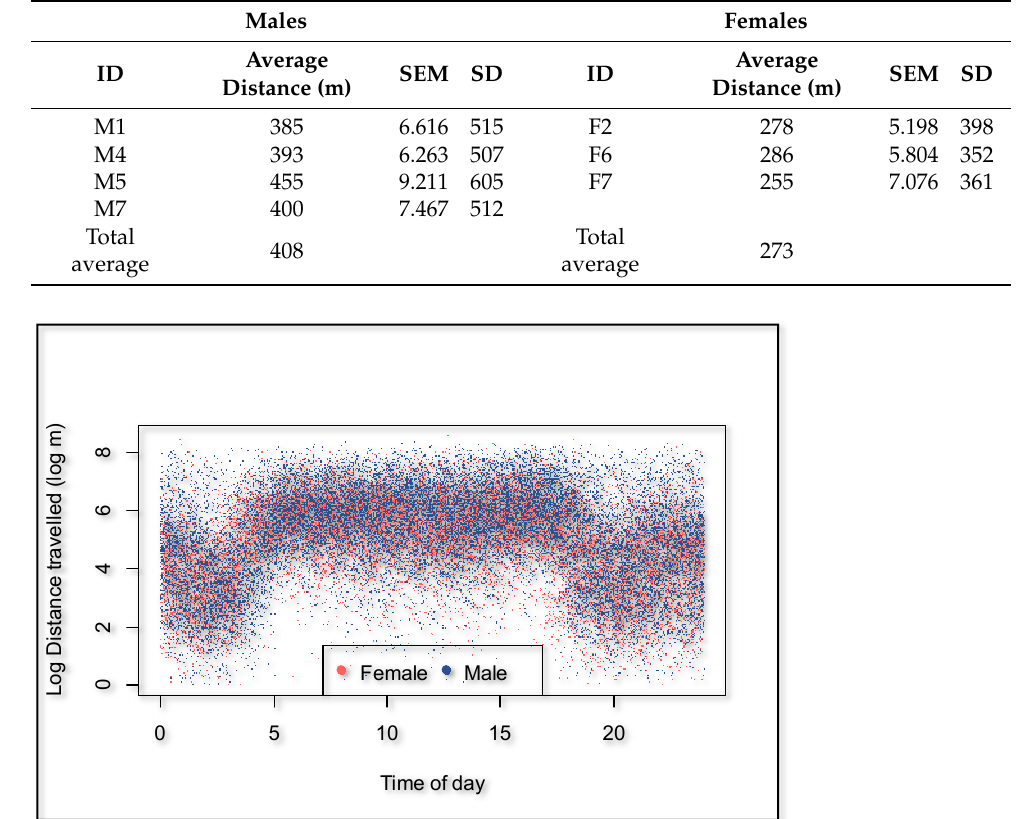
Table 2. Average distance traveled (m) per hour per individual.